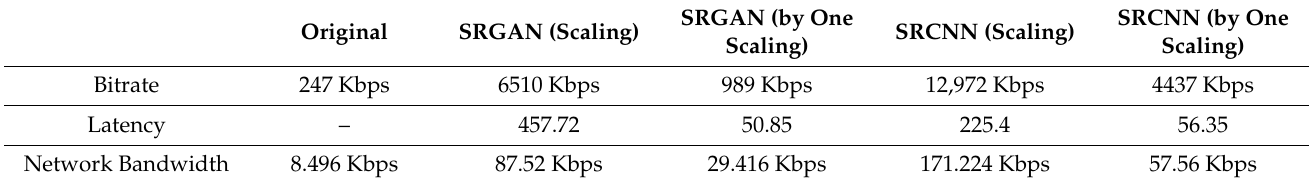
Table 6. Compare each network of broadcast streaming video.